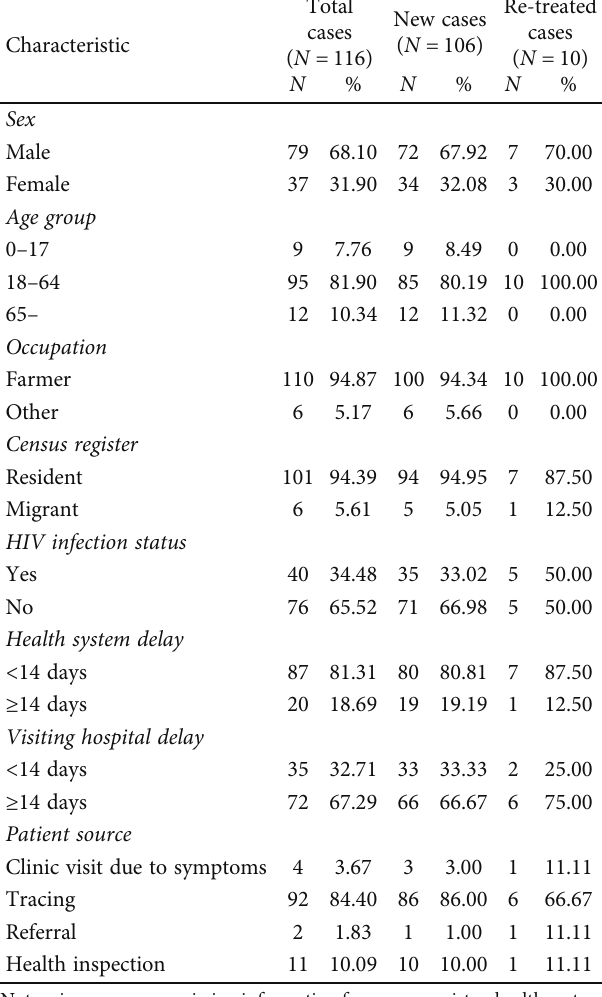
Table 1: Demographic information and clinical characteristics of 116 pulmonary tuberculosis cases in the Yi ethnic group, Sichuan,